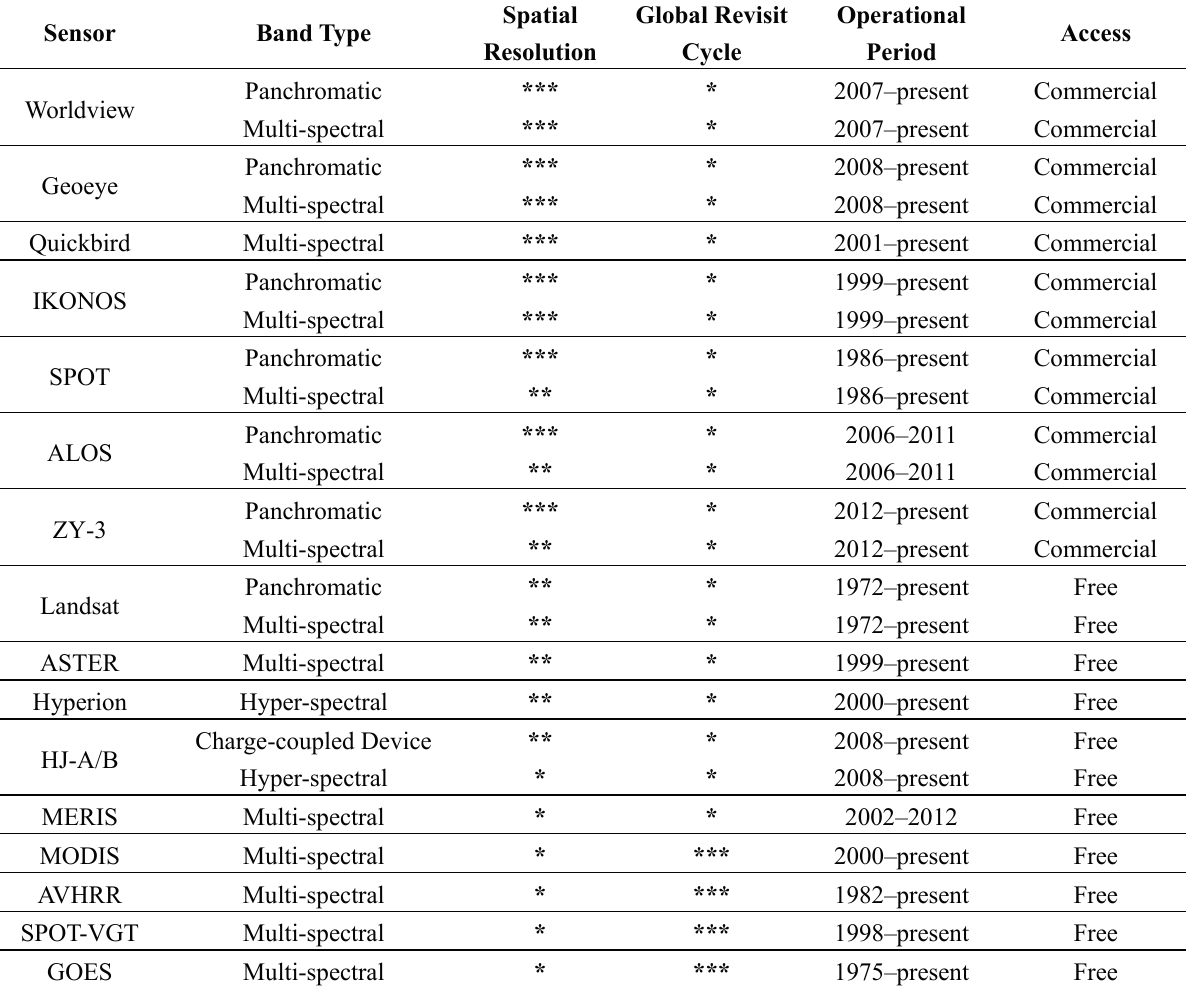
Table 1. Representative spatial and temporal resolution